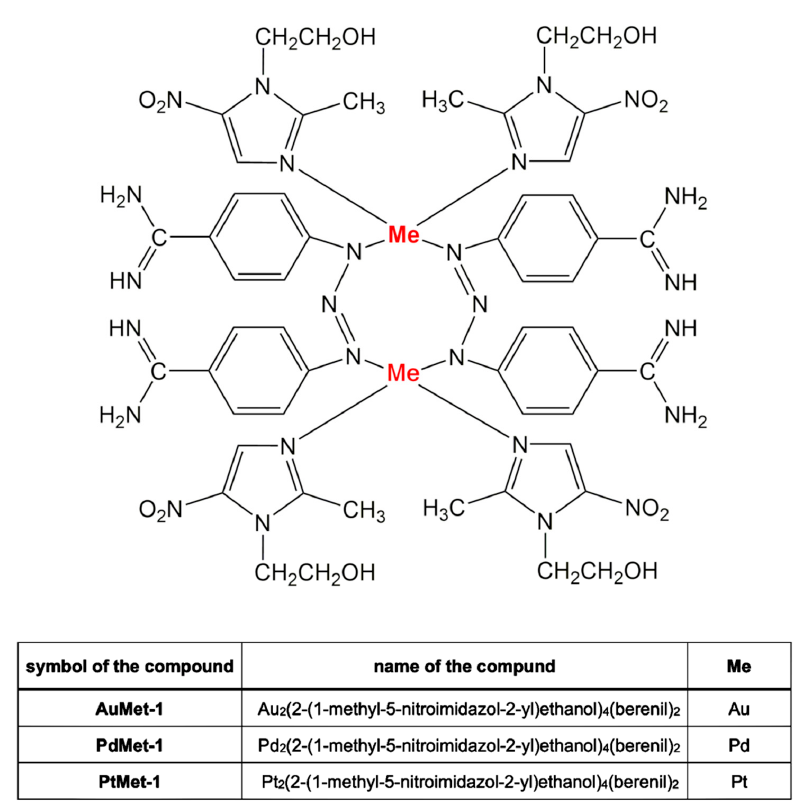
Figure 1. Structures of novel transition metal complexes (Au, Pd, Pt) with berenil and 2-(1-methyl-5- nitroimidazol-2-yl)ethanol.